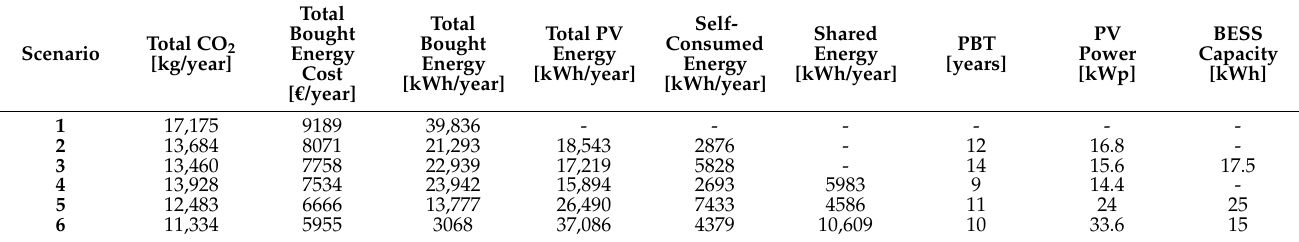
Table 7. Simulation results of the optimal sizing plant of the considered